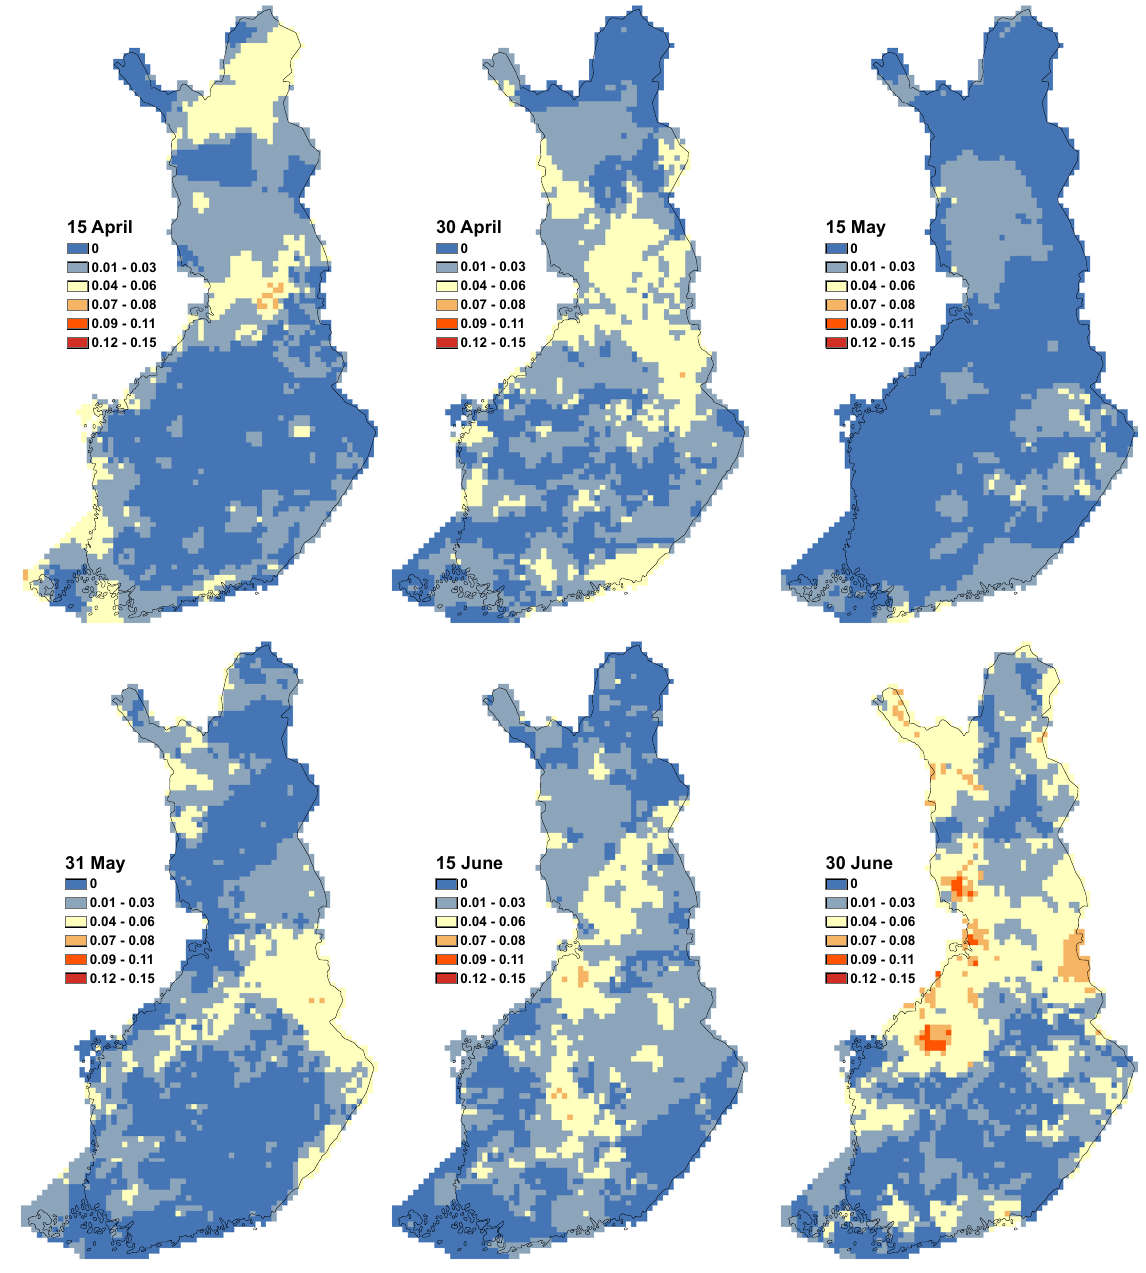
Fig. 3a. Probabilities of repeated rains lasting for at least for two weeks for the periods that ended on 15 April to 30